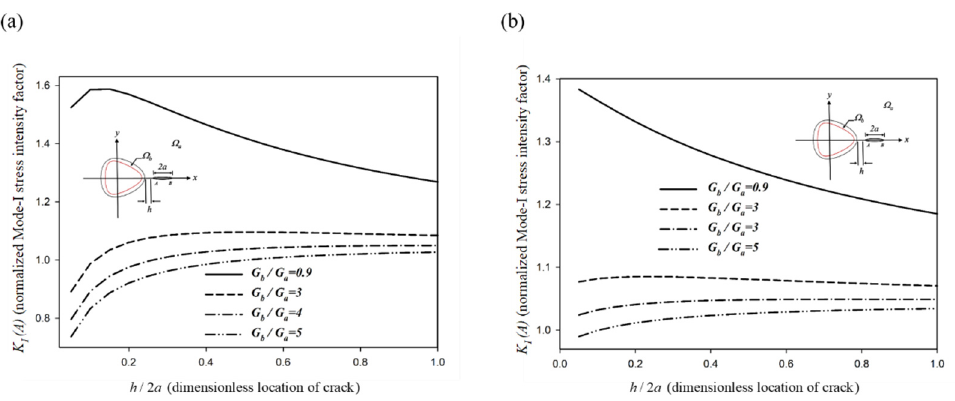
different material properties are shown in Figure 8.